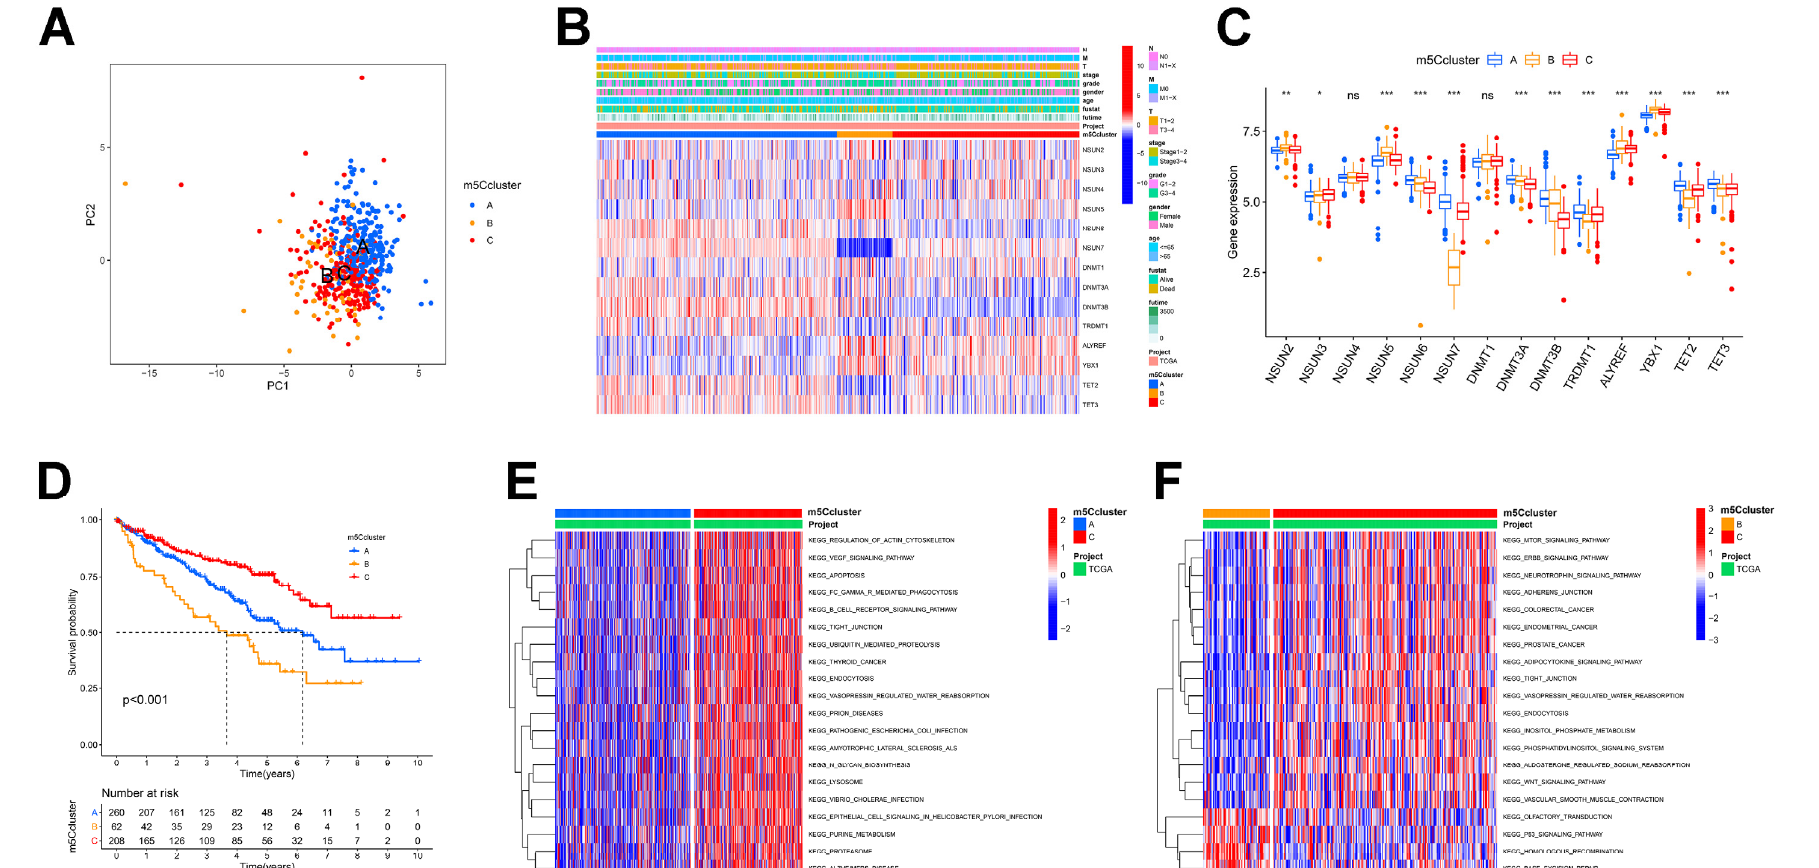
Figure 2. m5C clusters and corresponding biological features in ccRCC. ( A ) PCA for e transcriptome profiles of three m5C clusters. ( B ) Unsupervised clustering of 14 m5C regulators in TCGA-ccRCC cohorts. ( C ) mRNA expression distributions of 14 m5C regulators in three m5C cluster. Upper and lower ends of boxes represent interquartile range of values. ( D ) Kaplan–Meier curves for three m5C modification patterns. ( E , F ) GSVA showing activation states of biological pathways in distinct m5C clusters. ( E ) cluster A vs. cluster C; ( F ) cluster B vs. cluster C. * p < 0.05; ** p < 0.01; *** p < 0.001; ns is not significant.